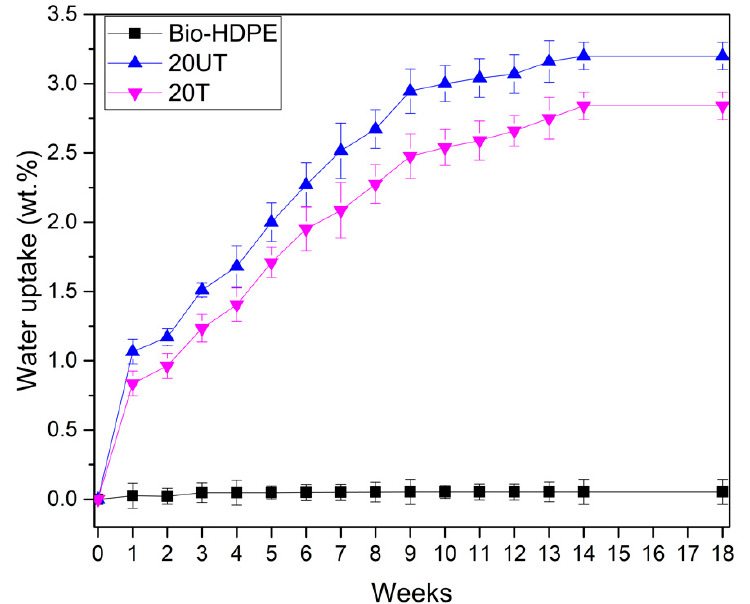
Figure 4. Water uptake of bio-based high-density polyethylene (Bio-HDPE) with 20 wt.% of untreated (20UT) and treated (20T) chia seed flour.